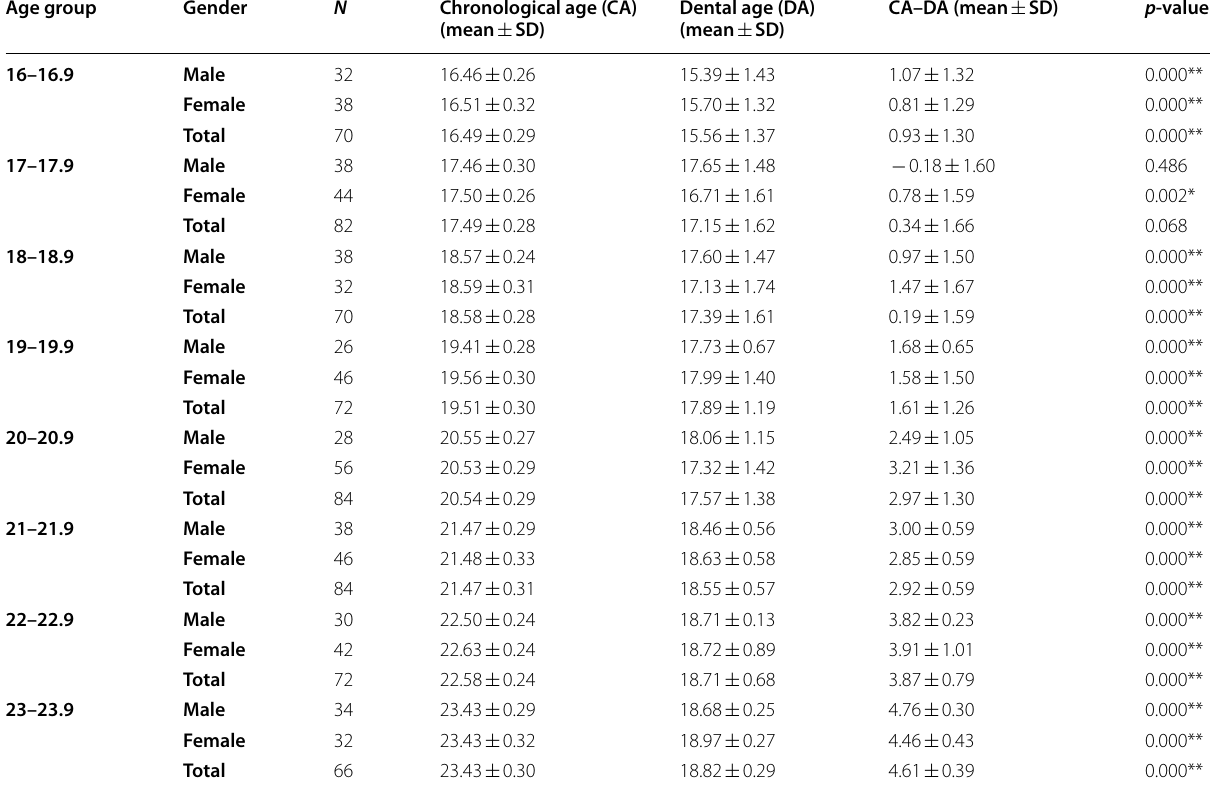
Table 2 The paired t -test was used to compare the differences between chronological age and dental age calculated using UT-age estimation